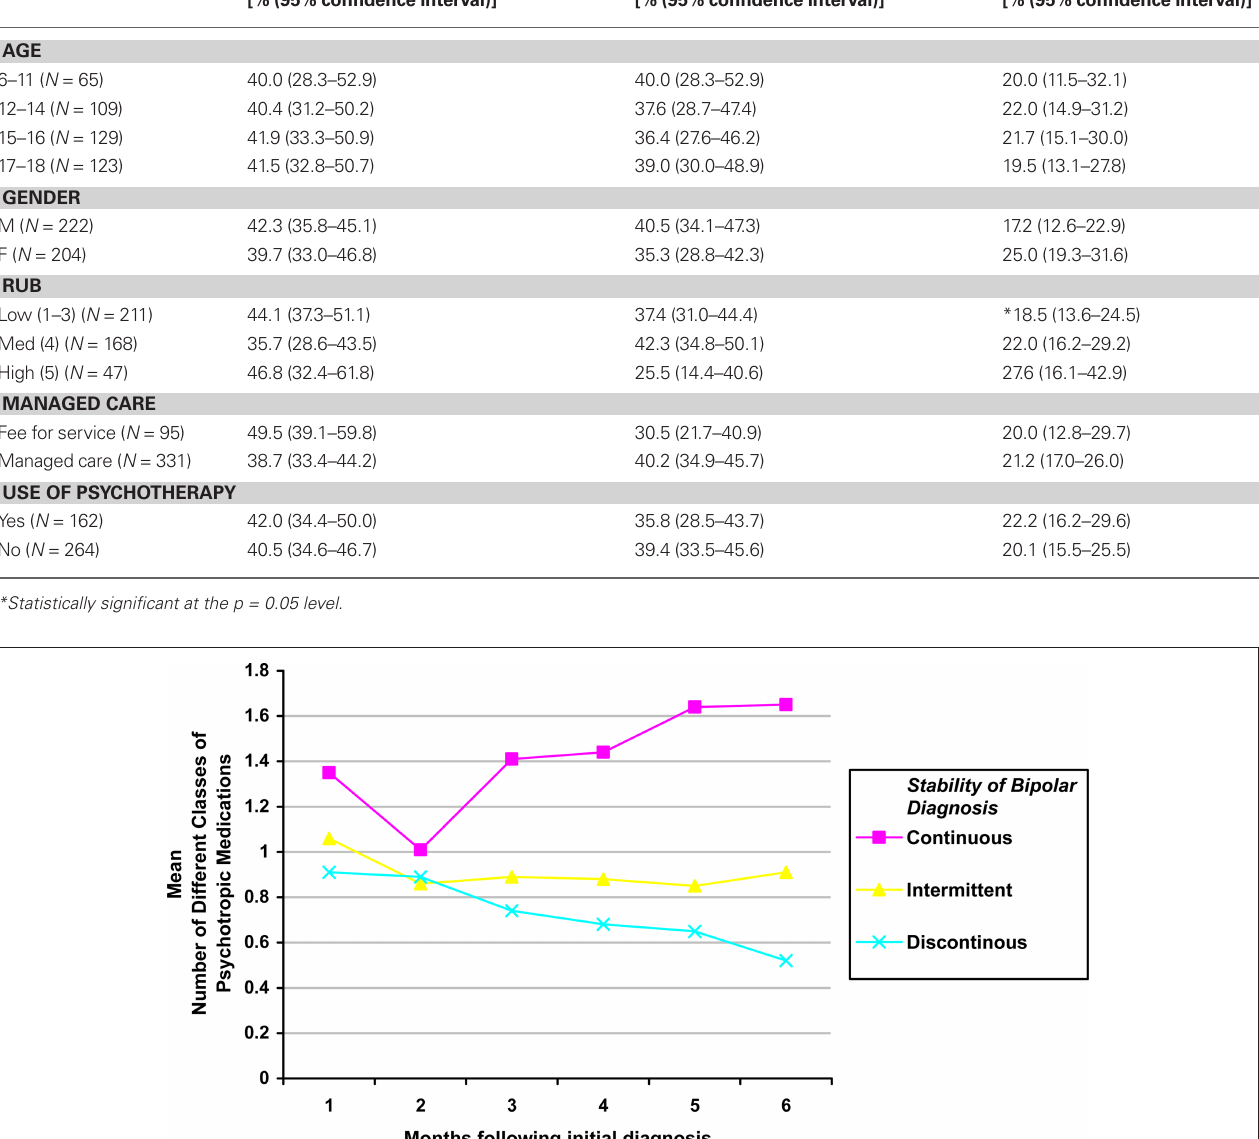
Table 2 incorporates timing of initiation and continuity of psy-